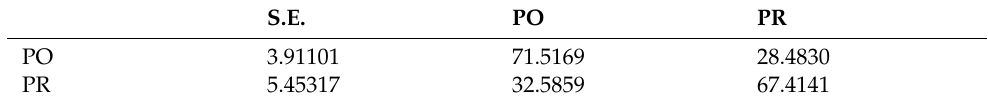
Table 5. Variance